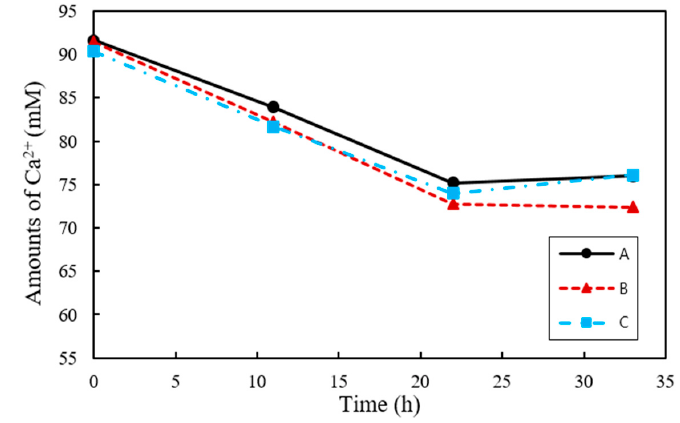
Figure 4. Ca 2+ consumption by S. pasteurii and B. thuringiensis in urea–calcium lactate medium over time.